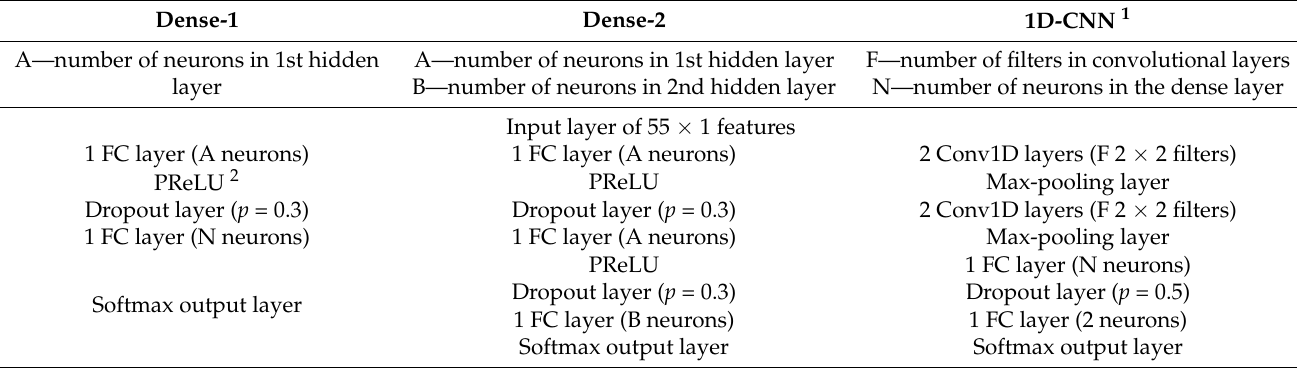
Table 1. Model configuration of neural network with their parameters.